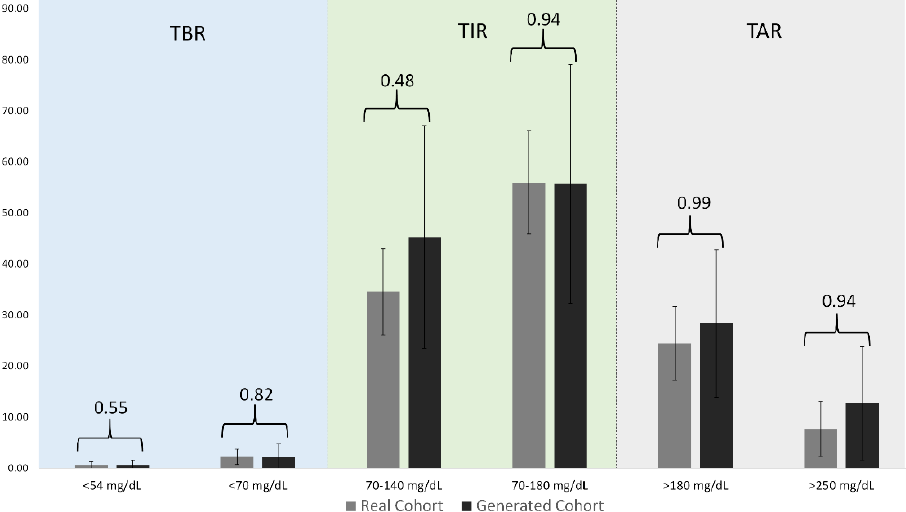
Figure 9. Times in standardized ranges of blood glucose for real and generated cohorts with corre- sponding p -values of the Ohio 6 patient data set.